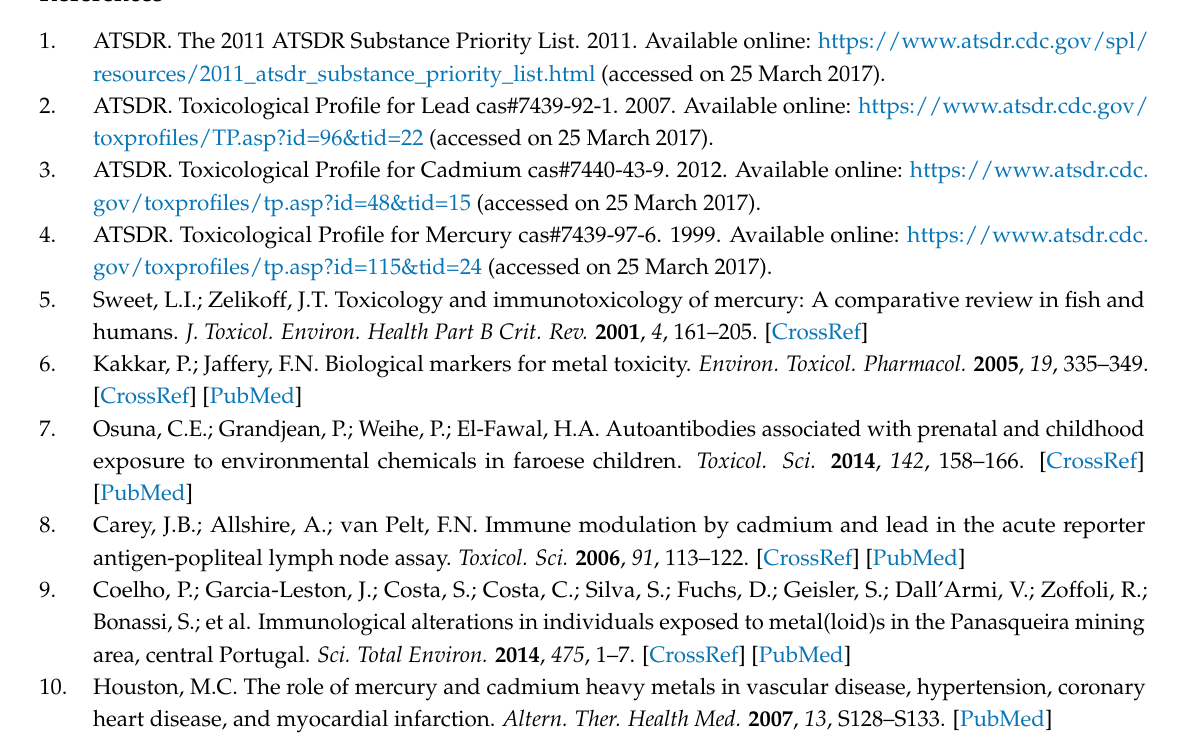
Table S1: SaBiosciences PCR Array Inflammatory Response and Autoimmunity Genes with Detectable Data for All 24 Participants (PAHS-077Z), Table S2: SaBiosciences PCR Array Human Stress and Toxicity Genes with Detectable Data for All 24 Participants